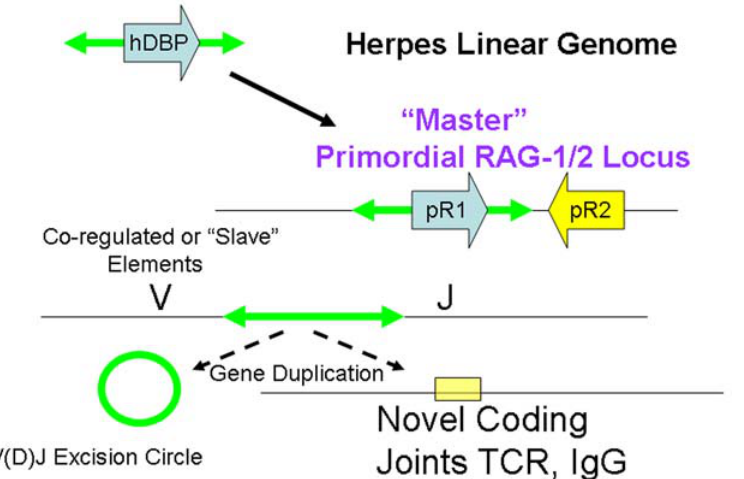
Figure 4. The Co-regulatory model including initial insertion of a primordial herpes virus recombinase (proto-RAG-1 denoted pR1) adjacent to a pre-existing RAG-2 like protein (denoted pR2) is shown. As shown, insertion of a herpes virus episome or linear genome adjacent to a RAG-2 like gene would provide a master co-regulated RAG-2/RAG-2 locus acting subsequently through co-evolving slave RSS sites in immunoglobulin or T-cell receptor genes. Co-evolving slave RSS could arise either from additional herpes or transposon insertions and gene duplication events or from co-evolution of endogenous sequences with some similarity to transposon or herpes virus termini in other genes such as those encoding B- and T-lymphocyte receptors (Figure 1). In contrast to the ‘‘RAG transposon’’ model, the co-regulatory model does not require the existence of a composite RAG-1/RAG-2 transposase or transposon and can also account for the experimental structure of the current RAG-1/RAG-2- like genes in the sea urchin and other deuterostomes that do not undergo V(D)J